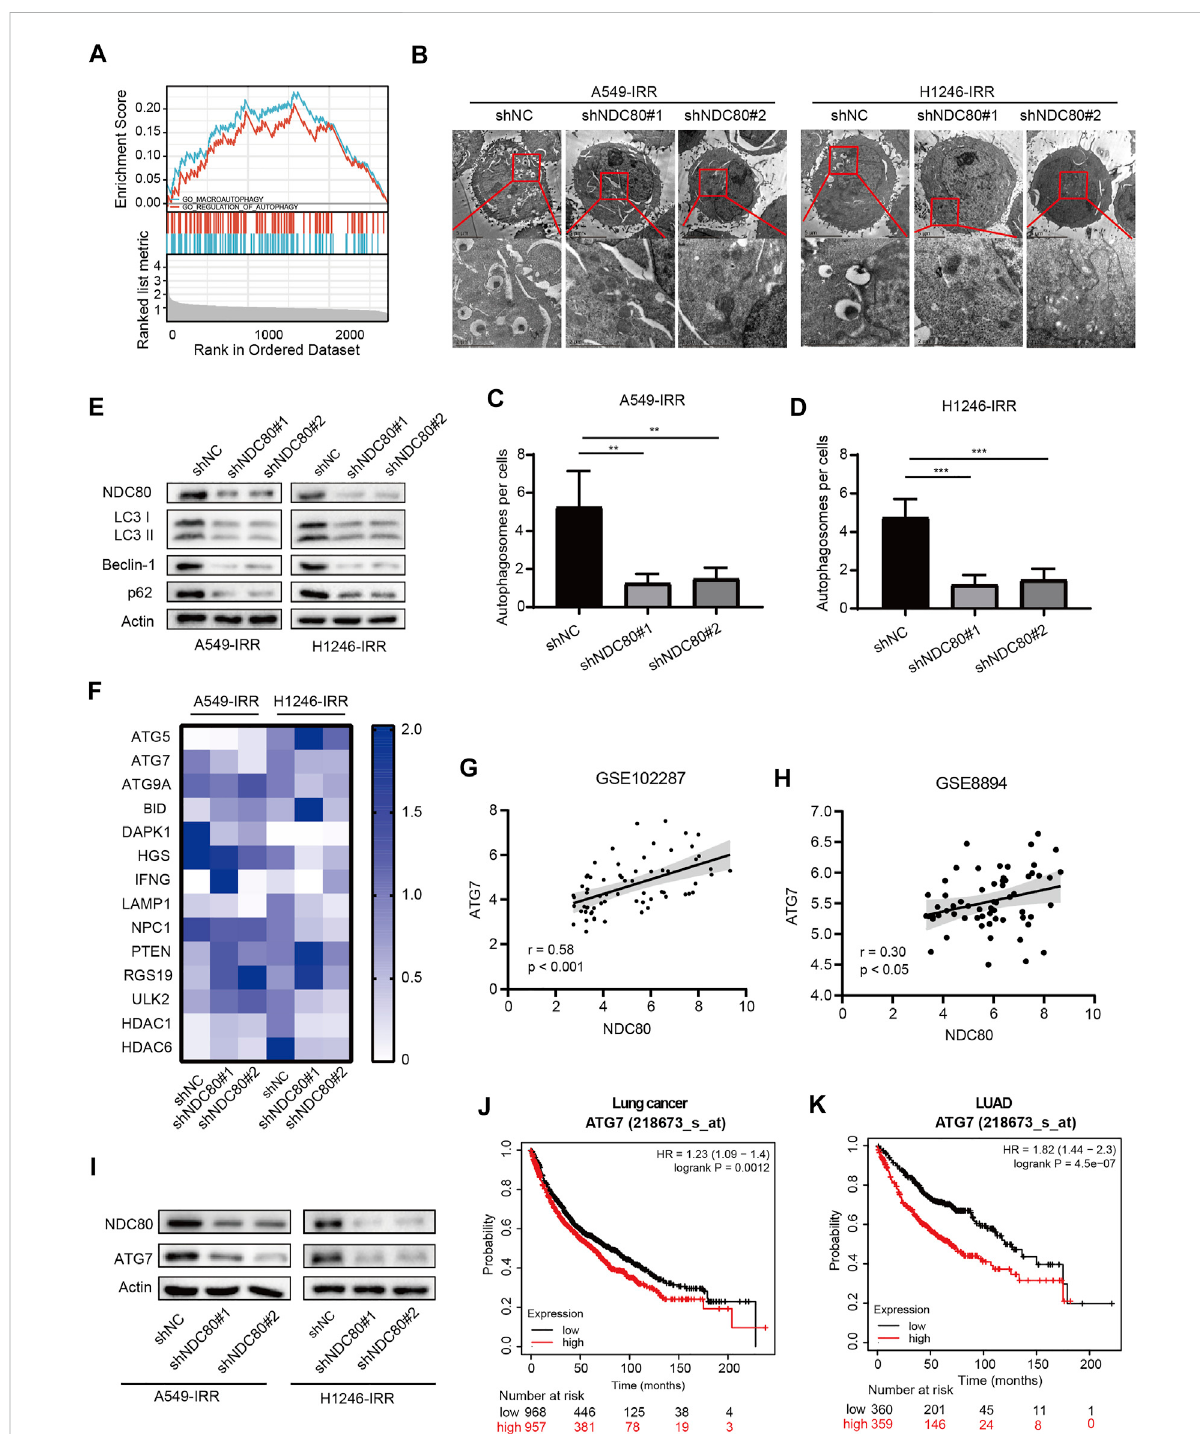
FIGURE 5 NDC80 regulates autophagy in lung cancer. (A) Analysis of the correlation between NDC80 and autophagy by GSEA analyses. (B – D) Autophagosome formation was detected by TEM analysis in A549-IRR and H1246-IRR cells with NDC80 knockdown. (E) After the knockdown of NDC80 in A549-IRR and H1246-IRR cells, LC3 II, Beclin-1, and p62 protein levels were detected. (F) The heatmap shows the mRNA levels of 14 autophagy-relevant genes identi fi ed in A549-IRR and H1246-IRR cells. (G,H) Validation of the correlation between NDC80 and ATG7 in two datasets,i.e.,GSE102287 (G) andGSE8894 (H) intheGEOdatabase. (I) AnalysisoftheproteinexpressionlevelofATG7inNDC80-reducedA549-IRR andH1246-IRRcells. (J,K) AnalysisoftheprognosticvalueofATG7inlungcancer (J) andLUAD (K) ,throughKaplan-Meieranalysis.** p < 0.01;*** p <